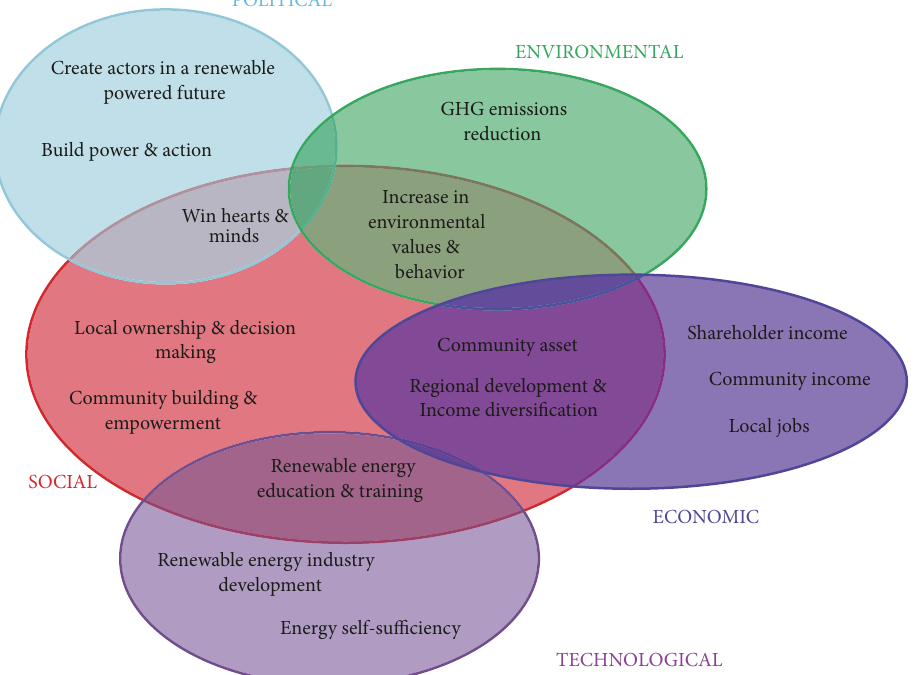
Figure 1: Renewables for sustainable development [6].